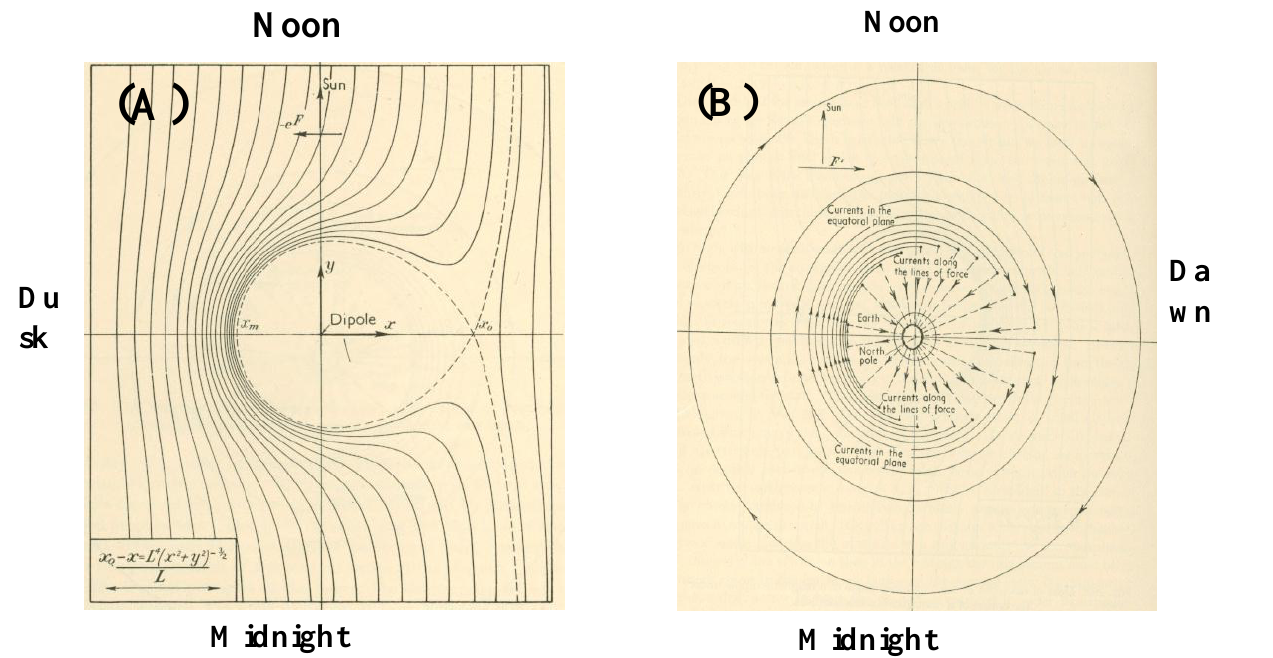
Figure 6. Alfv´en’s concept of (A) energetic electron drift paths in the equatorial plane of a dipolar magnetic field with a uniform dusk-to- dawn, and (B) the resultant ring current in the equatorial plane. Note that Alfv´en’s ring current is highly asymmetric requiring that it close through the auroral ionosphere via magnetic field aligned currents – i.e. Birkeland currents (Størmer,